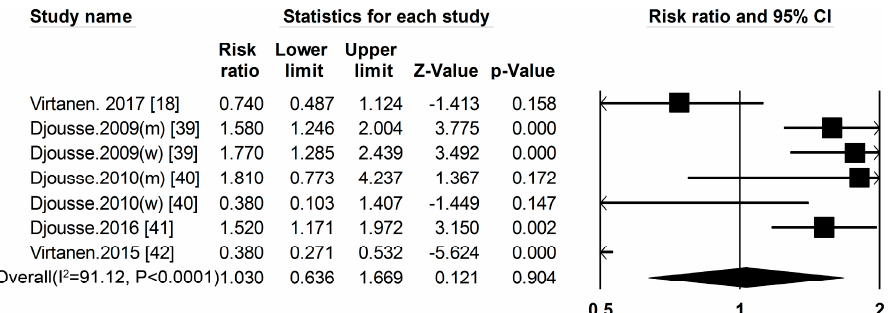
Figure 7. Egg and type 2 diabetes RRs for the highest vs. the lowest intake in all subjects. The RR of each study is represented by a square, 95% CI are represented by the horizontal lines, and the diamond represents the estimate and its 95% CI.